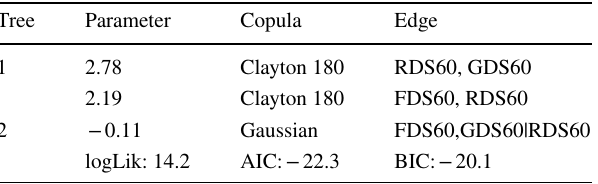
Table 6 Study results of D-Vine copula for selecting copula function and type of tree in Tapik basin